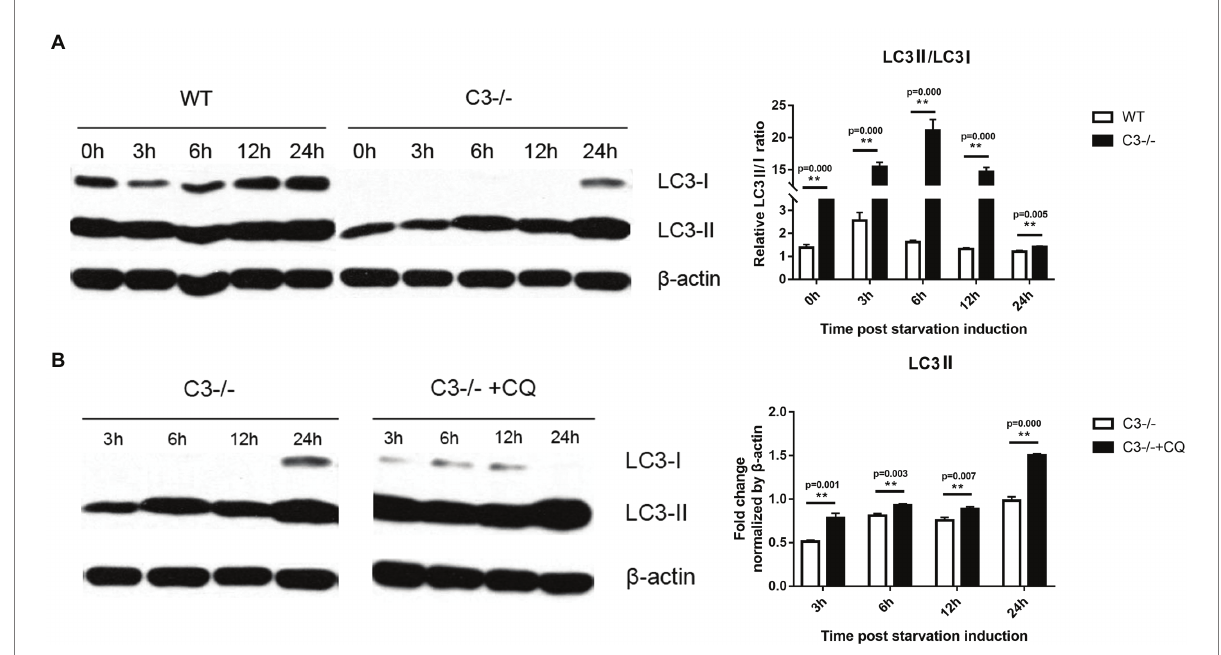
FIGURE 1 Effects of local complement C3 Knock-out on the autophagy of macrophages. (A) Western blot was used to detect the effect of C3 knock-out on the LC3II/LC3I ratio in macrophages at 0, 3, 6, 12, and 24 h after starvation induction. ** p < 0.01 indicates WT group vs. C3 − / − group. (B) Western blot was used to detect the effect of CQ on the level of LC3II in C3 − / − mice’ macrophages at the 3, 6, 12, and 24 h time point of starvation induction. ** p < 0.01 indicates C3 − / − group vs. C3 − / − + CQ group. n = 5 in each group. Data are the mean ± SD. WT, wild-type mice’ macrophages; C3 − / − , macrophages from C57BL/6 J mice with C3 knock-out; C3 − / − + CQ, macrophages from C3 − /- C57BL/6 J mice under starvation induction at the same time adding CQ. CQ, chloroquine. Intensity was measured by ImageJ